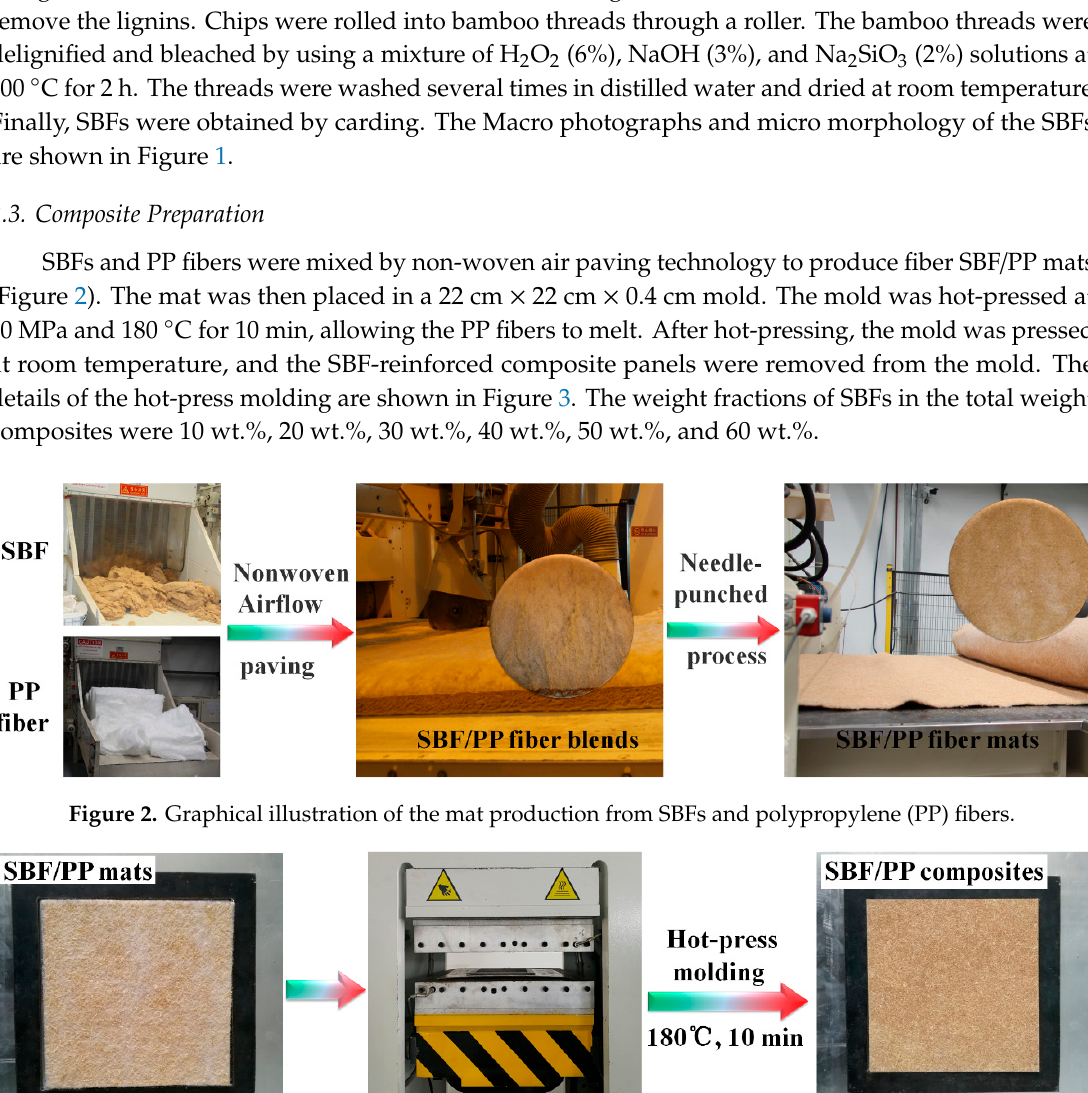
Figure 1. Macro images and micro morphology of bamboo: ( a ) bamboo, ( b ) cross section of cylindrical